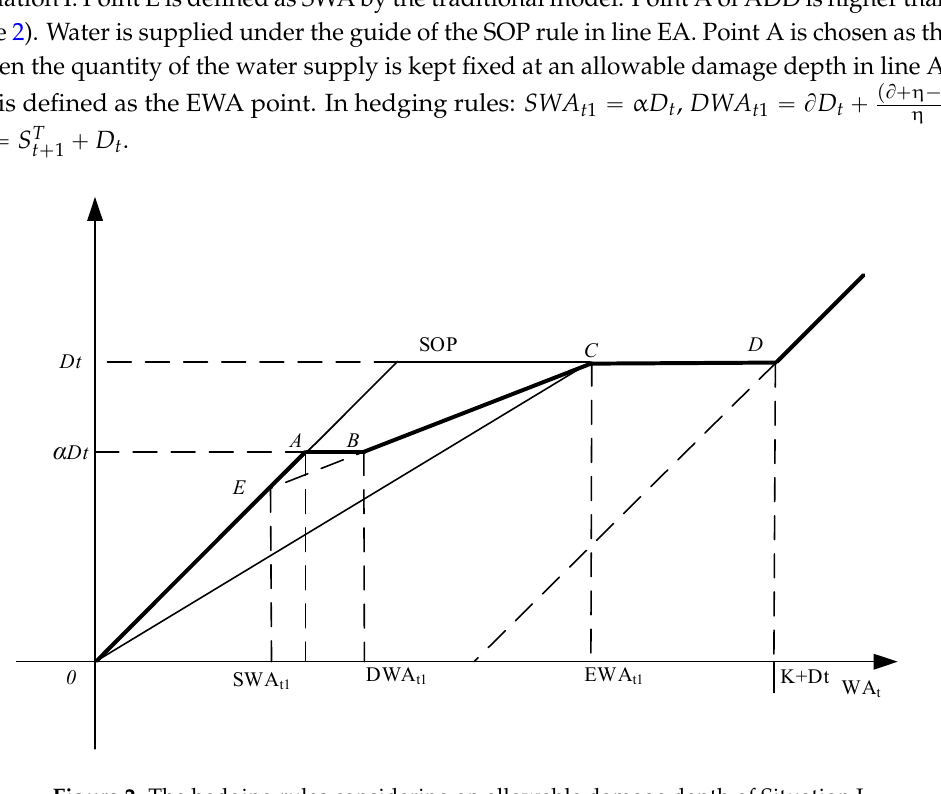
Figure 2. The hedging rules considering an allowable damage depth of Situation I.